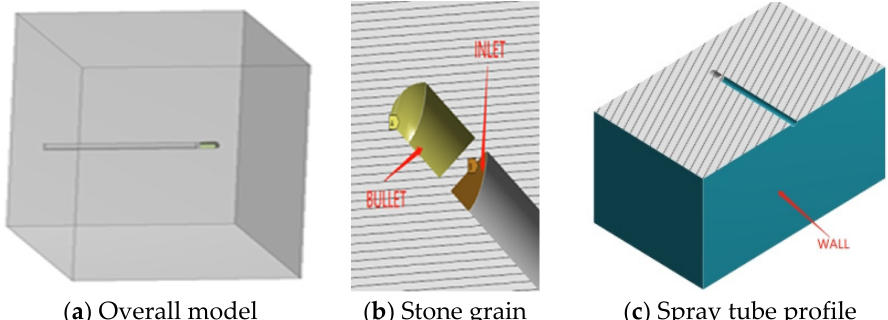
Figure 1. Geometric model and boundary conditions. ( a ) The overall geometric model. ( b ) The bullet and drive airflow inlet. ( c ) The bullet jet stream profile.